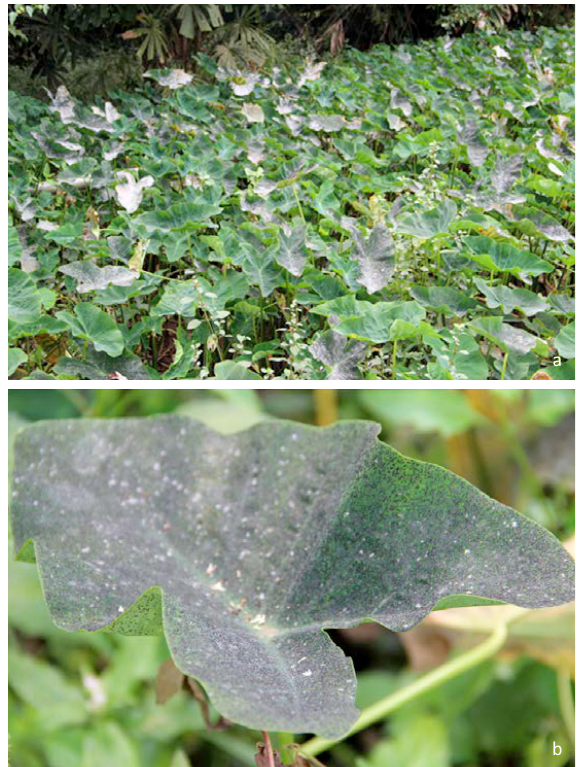
(Fig. 4) urn:lsid:indexfungorum.org:names: 807687 Materials examined: TBGT 6676 (holotype) PBL